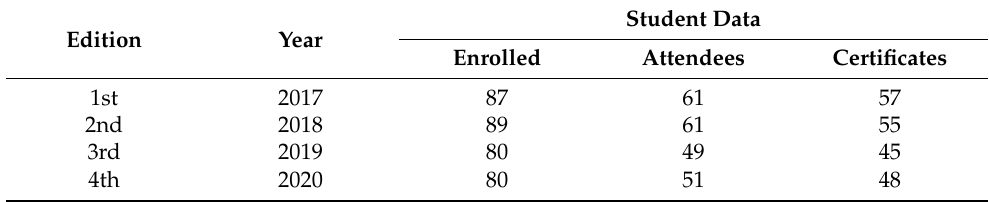
Table 1. List of workshop editions and students. Own elaboration.